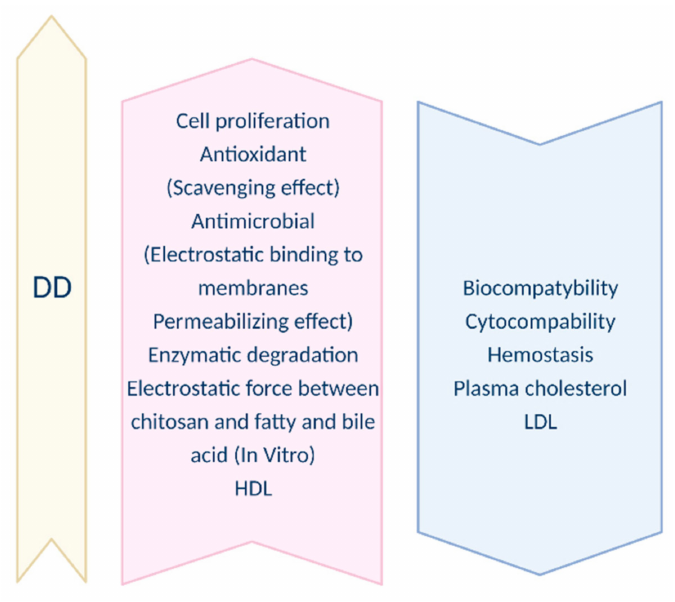
Figure 3. DD influence on biological